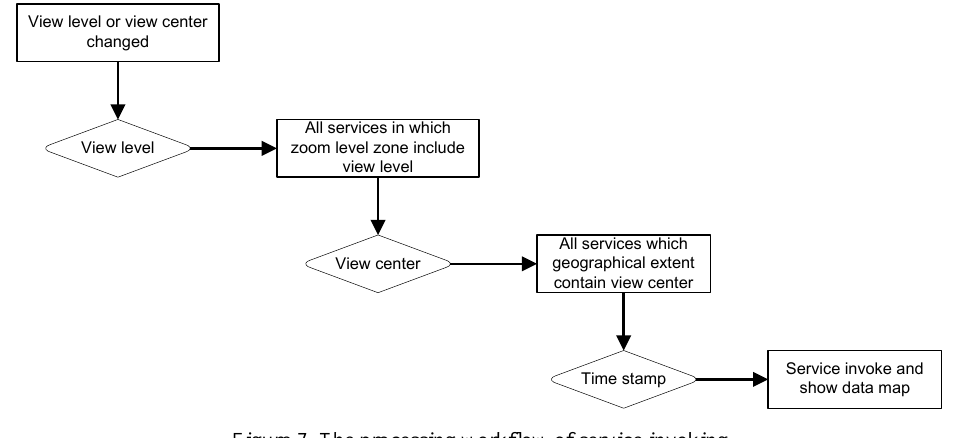
Figure 7. The processing workflow of service